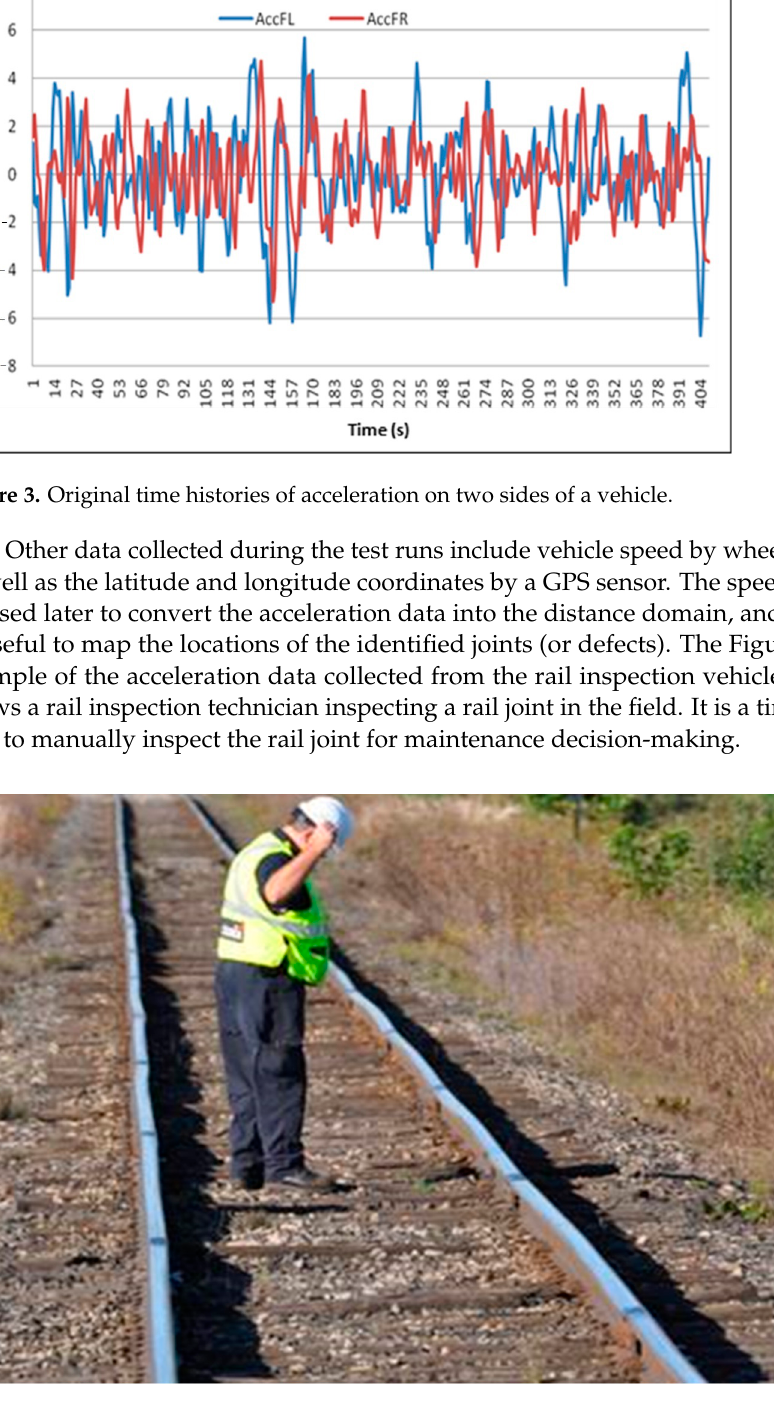
Figure 4. Manual joint inspection by a technician in the